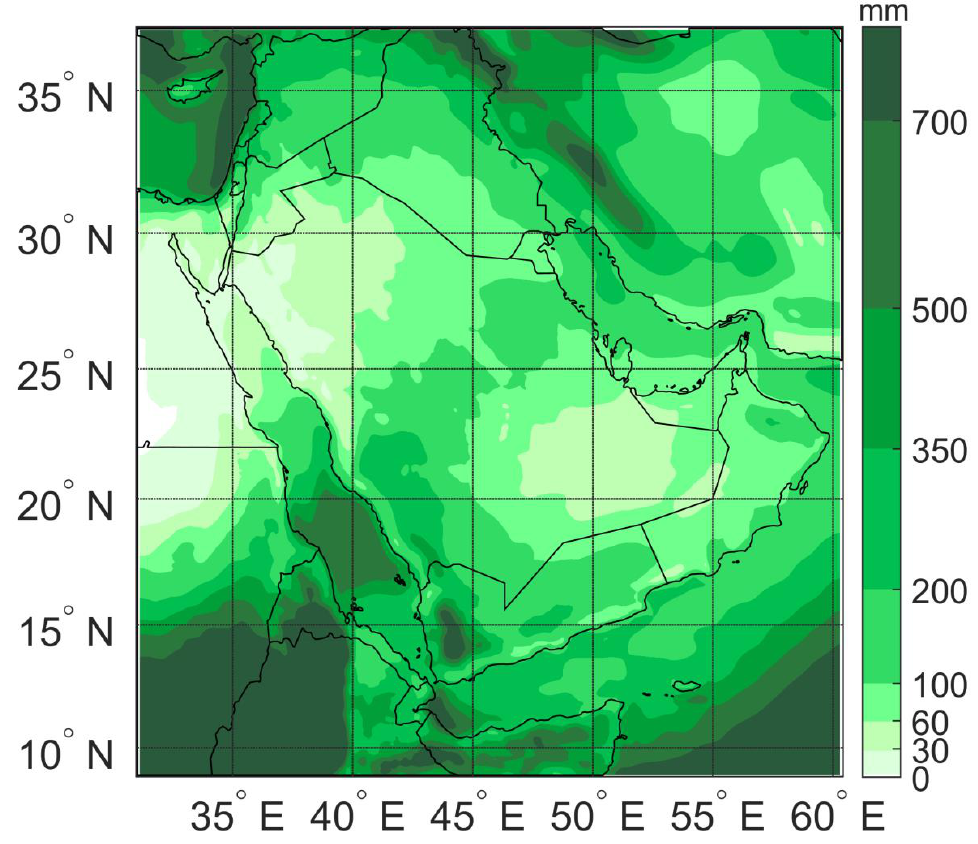
Figure 7. Mean annual accumulated precipitation for the years 1986–2015 (model output). During March, the desert front that forms during the transitional period of spring across southern Egypt and the northern Red Sea into central Saudi Arabia results in the formation of a secondary wave over the central Red Sea (Figure 9b) associated with extensive thunderstorms and intense precipitation. In April, thunderstorms and heavy rain are associated with convective activity due to the passage of desert fronts and the thermal trough of